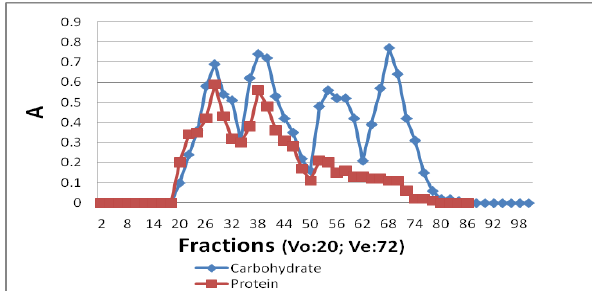
Figure 1. Gel-chromatography of crude polysaccharides (P) on Sephadex G-100. Table 1. Properties of fractions A, B, C, and D.